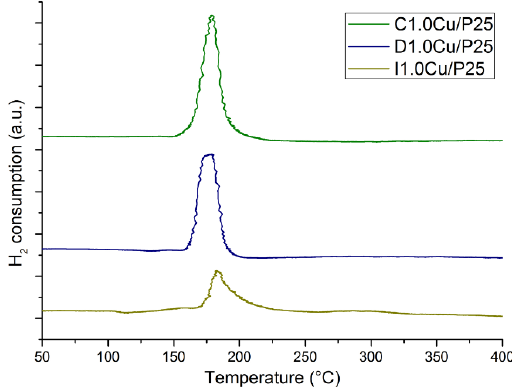
Figure 5. TPR of I1.0Cu/P25, D1.0Cu/P25 and C1.0Cu/P25.